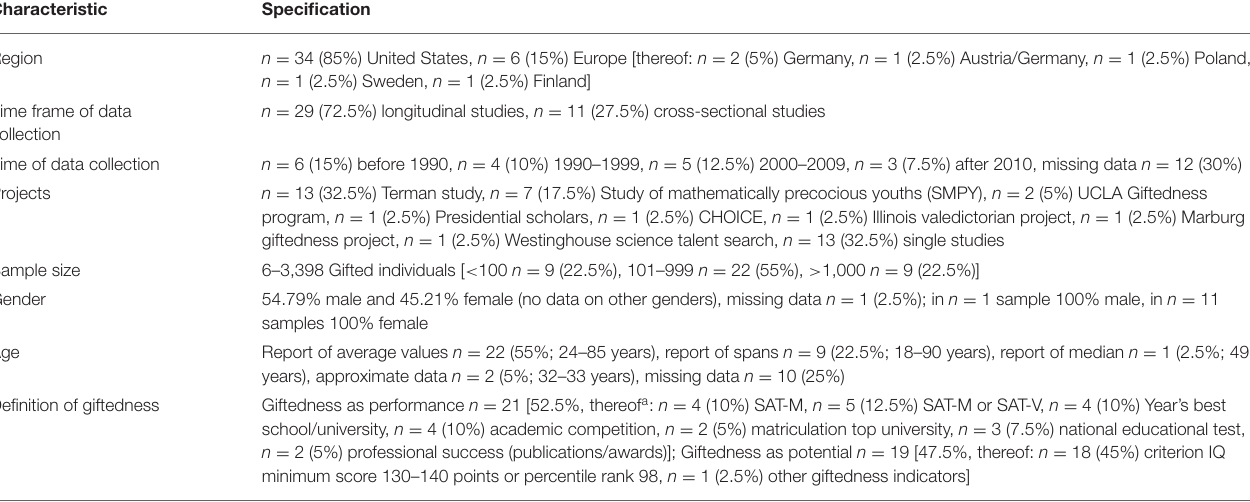
TABLE 1 | Description of included studies.